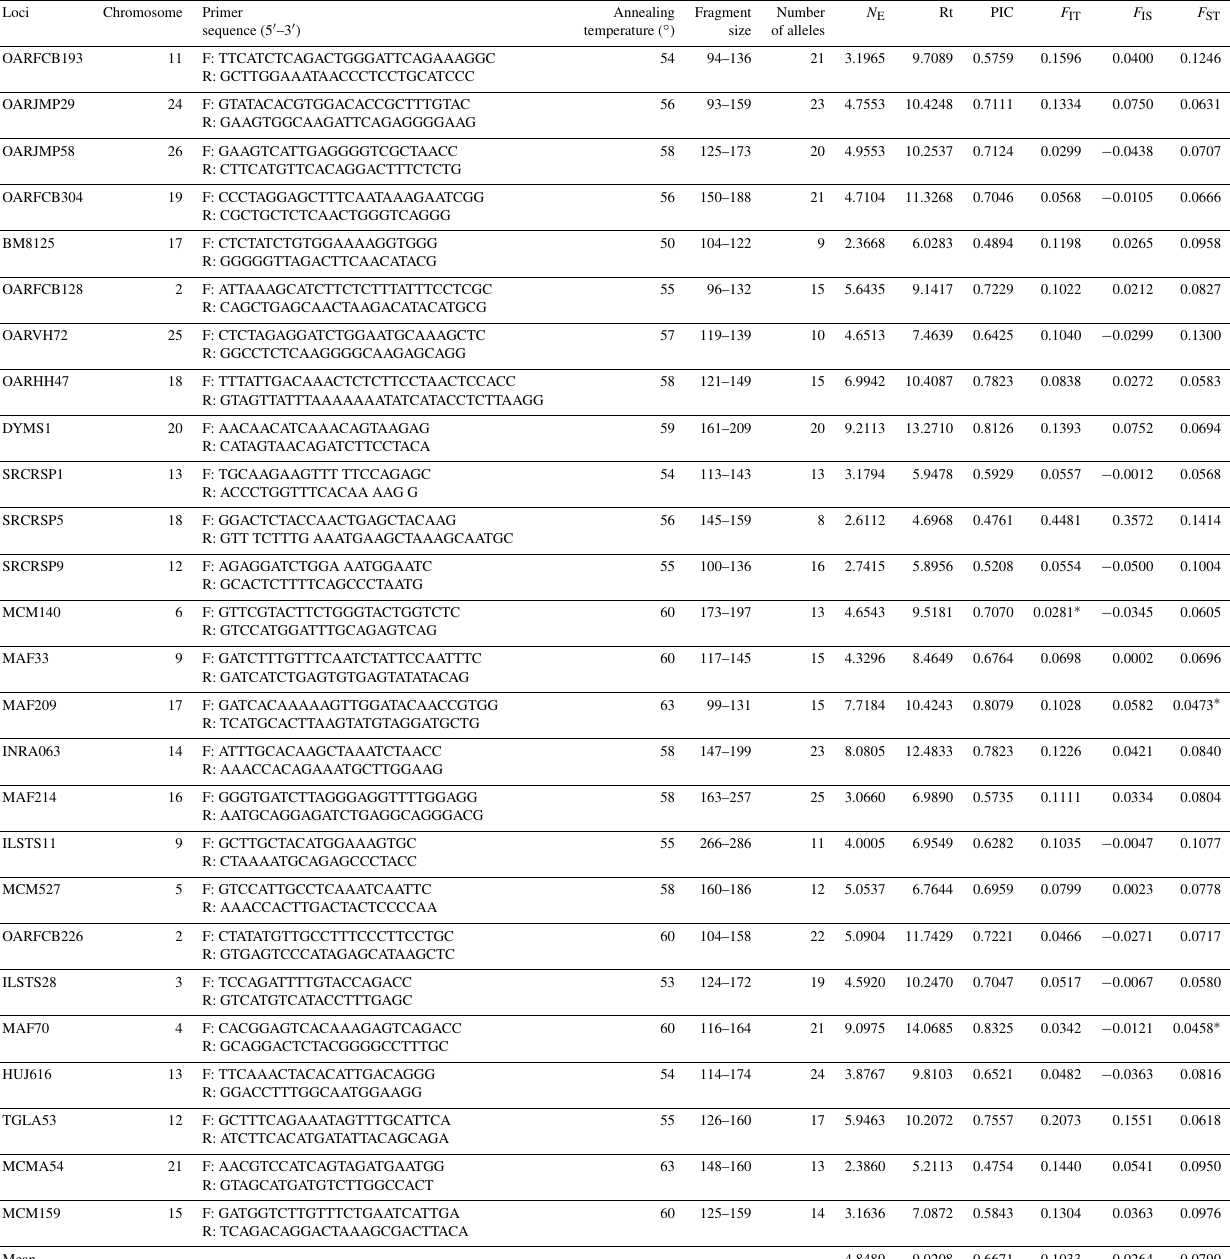
Table 2. Information of amplification and genetic parameter statistics for each microsatellite locus. Loci Chromosome